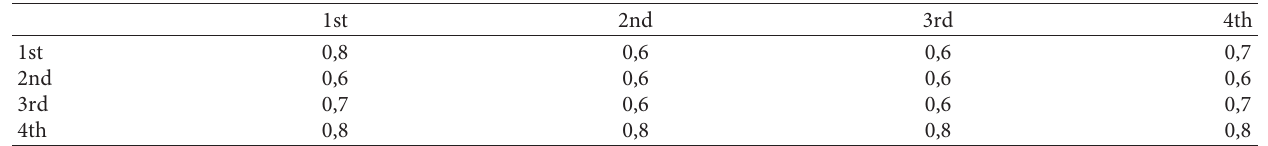
Figure 10: Entering the values of the robotic properties of the group of red and blue in the second experiment. Table 3: The result of the solution to the goal assignment